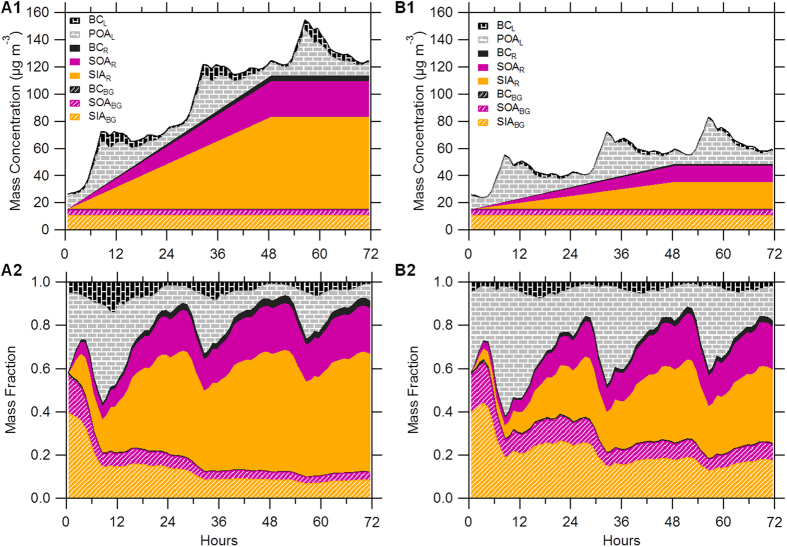
A conceptual framework on primary and secondary aerosol evolution.The 72 hr evolution of mass concentrations and mass fractions of primary and secondary aerosol without emission controls before APEC (A1 and A2) and with the emission controls during APEC (B1 and B2). The evolution of primary species starts from noontime with te lowest concentrations in a day. SIABG, SOABG, and BCBG refer to the regional background concentrations of secondary inorganic aerosol, secondary organic aerosol, and black carbon. SIAR, SOAR, and BCR are the concentrations from regional transport which are calculated based on the accumulation rates during the episodes of 16–17 October and 7–8 November, respectively. BCL and POAL refer to the local sources that were calculated from the diurnal profiles of POA (HOA, COA, and BBOA) and BC (regional background and transport were excluded) before and during APEC. A2 and B2 show the evolution of the mass fraction of aerosol species from different sources.